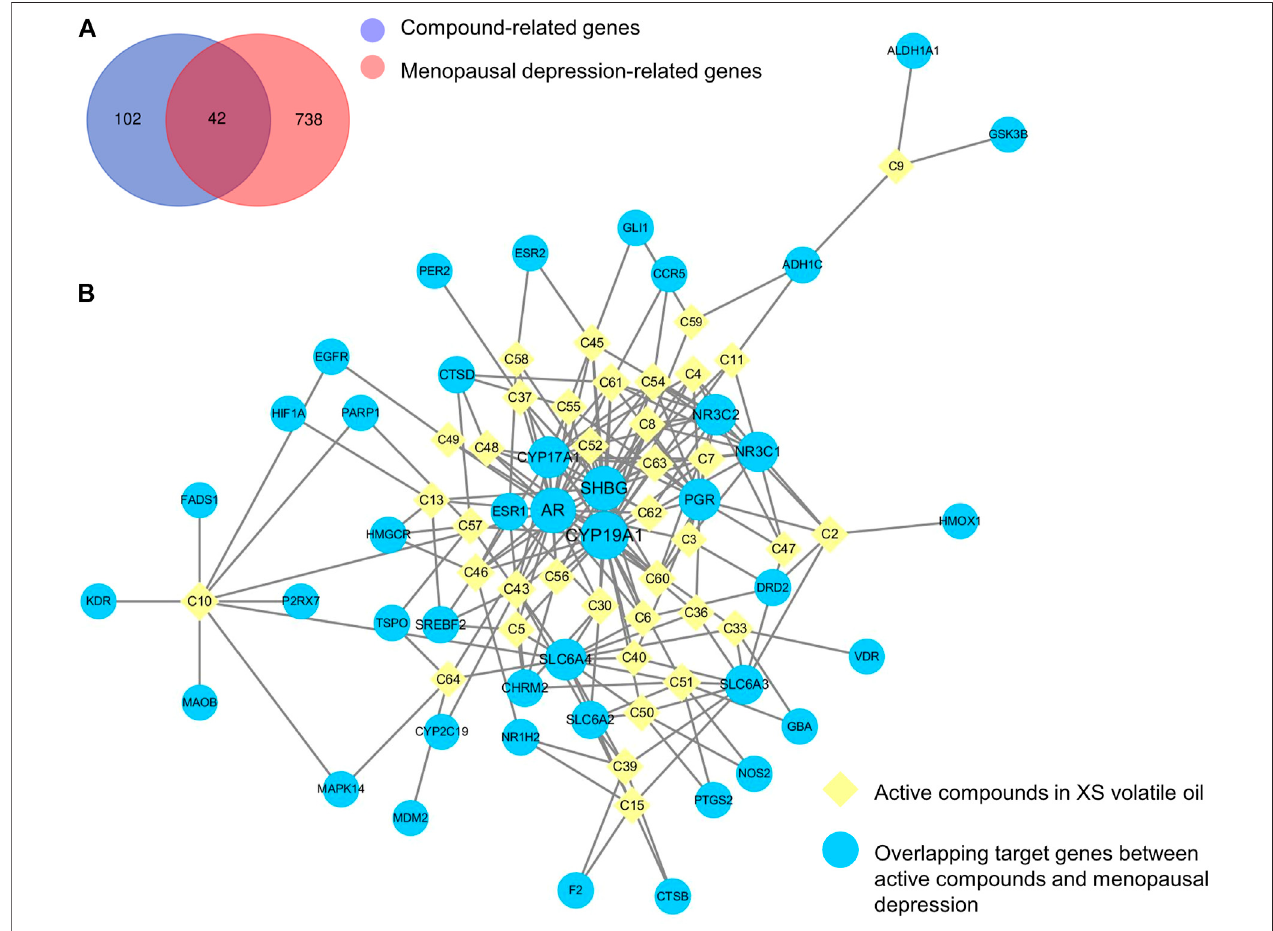
FIGURE 3 | Venn diagram of overlapping genes between compound and menopausal depression – related genes (A) and compound – target network of XS volatile oil against menopausal depression (B) .